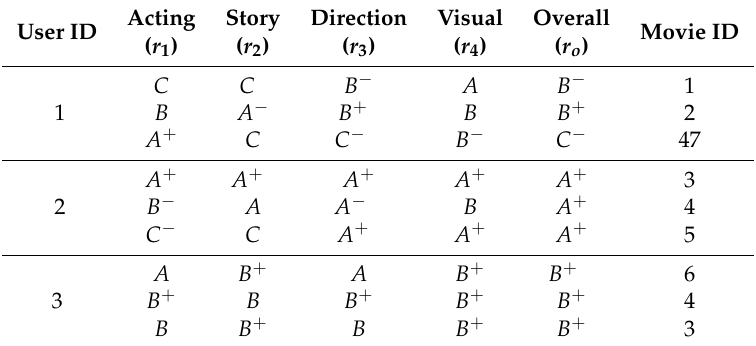
Table 1. Sample of the Yahoo!Movies data det for multi-criteria recommender systems.